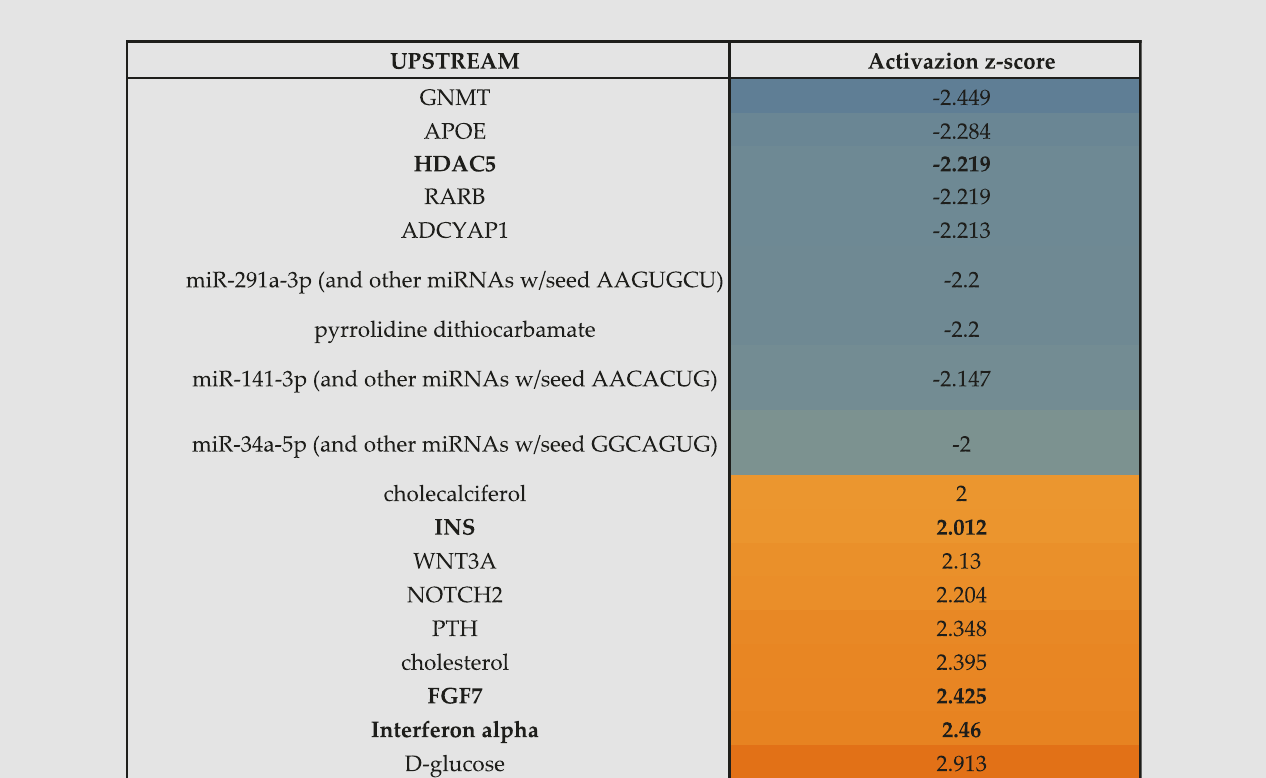
The four upstream systems deemed most interesting and discussed in more detail are identi fi ed in